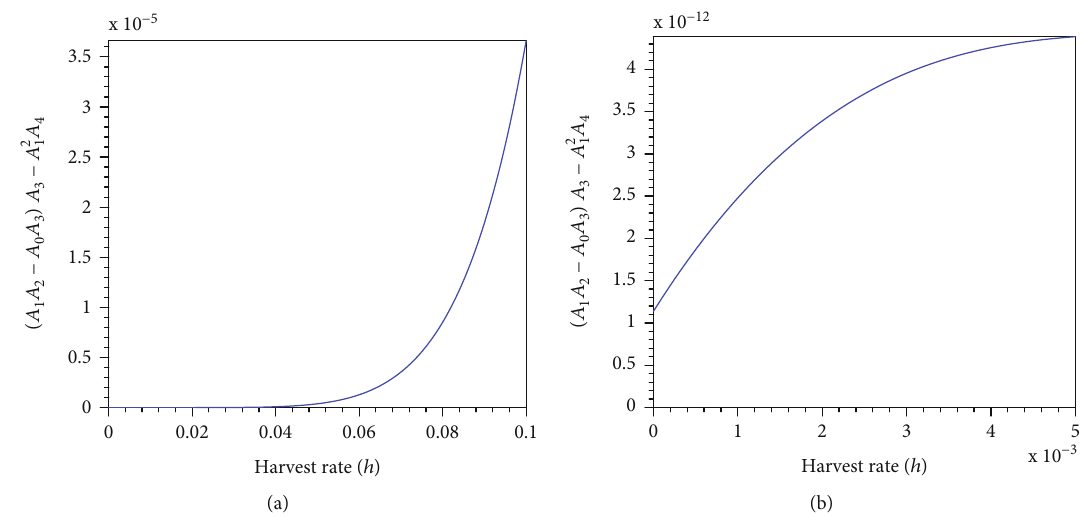
− A − A 2 Þ A and A A A 1 2 0 3 3 4 1